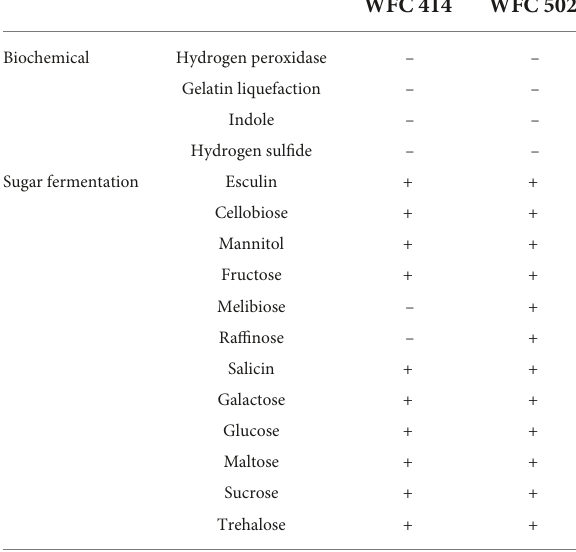
TABLE 2 Biochemical and sugar fermentation characteristics of WFC 414 and WFC